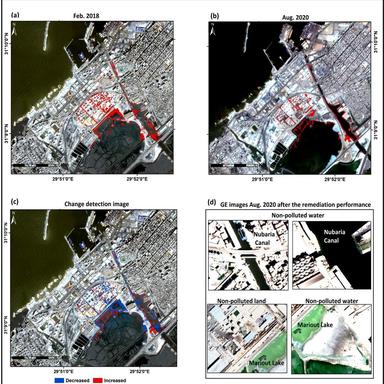
(a, b) Planet images showing the oil spill contamination in February 2018 and August 2020, respectively, by red color. (c) A change detection map for the oil spill contamination distribution during the period 2018 to 2020. (d) High resolution GE images in 2020 showing the effectiveness of the suggested remediation action in 2020 to protect the land and aquatic environments from oil spills pollution (for comparison, see b, c, d, and e) along the coastal zones.